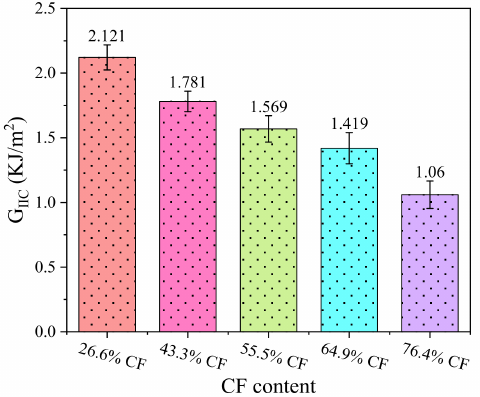
Figure 9. G IIC of composite with different fiber mass